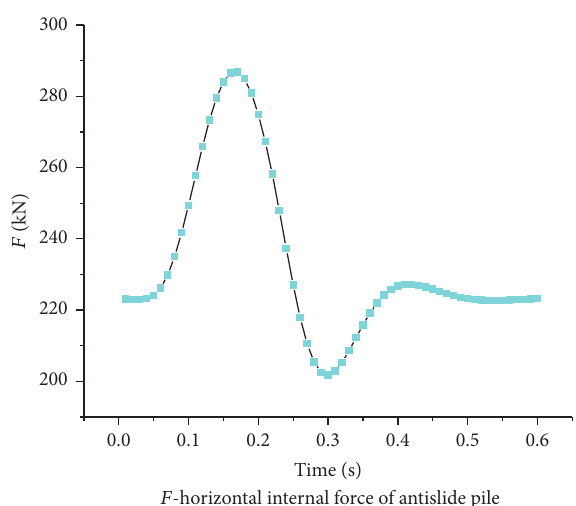
Figure 12: Antisliding internal force response effect curve.